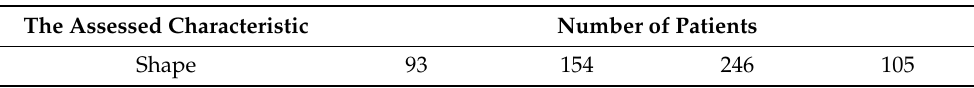
Table A5. Subjective scale of the outcomes of the operation completed by the patients allocated in the control group just after the